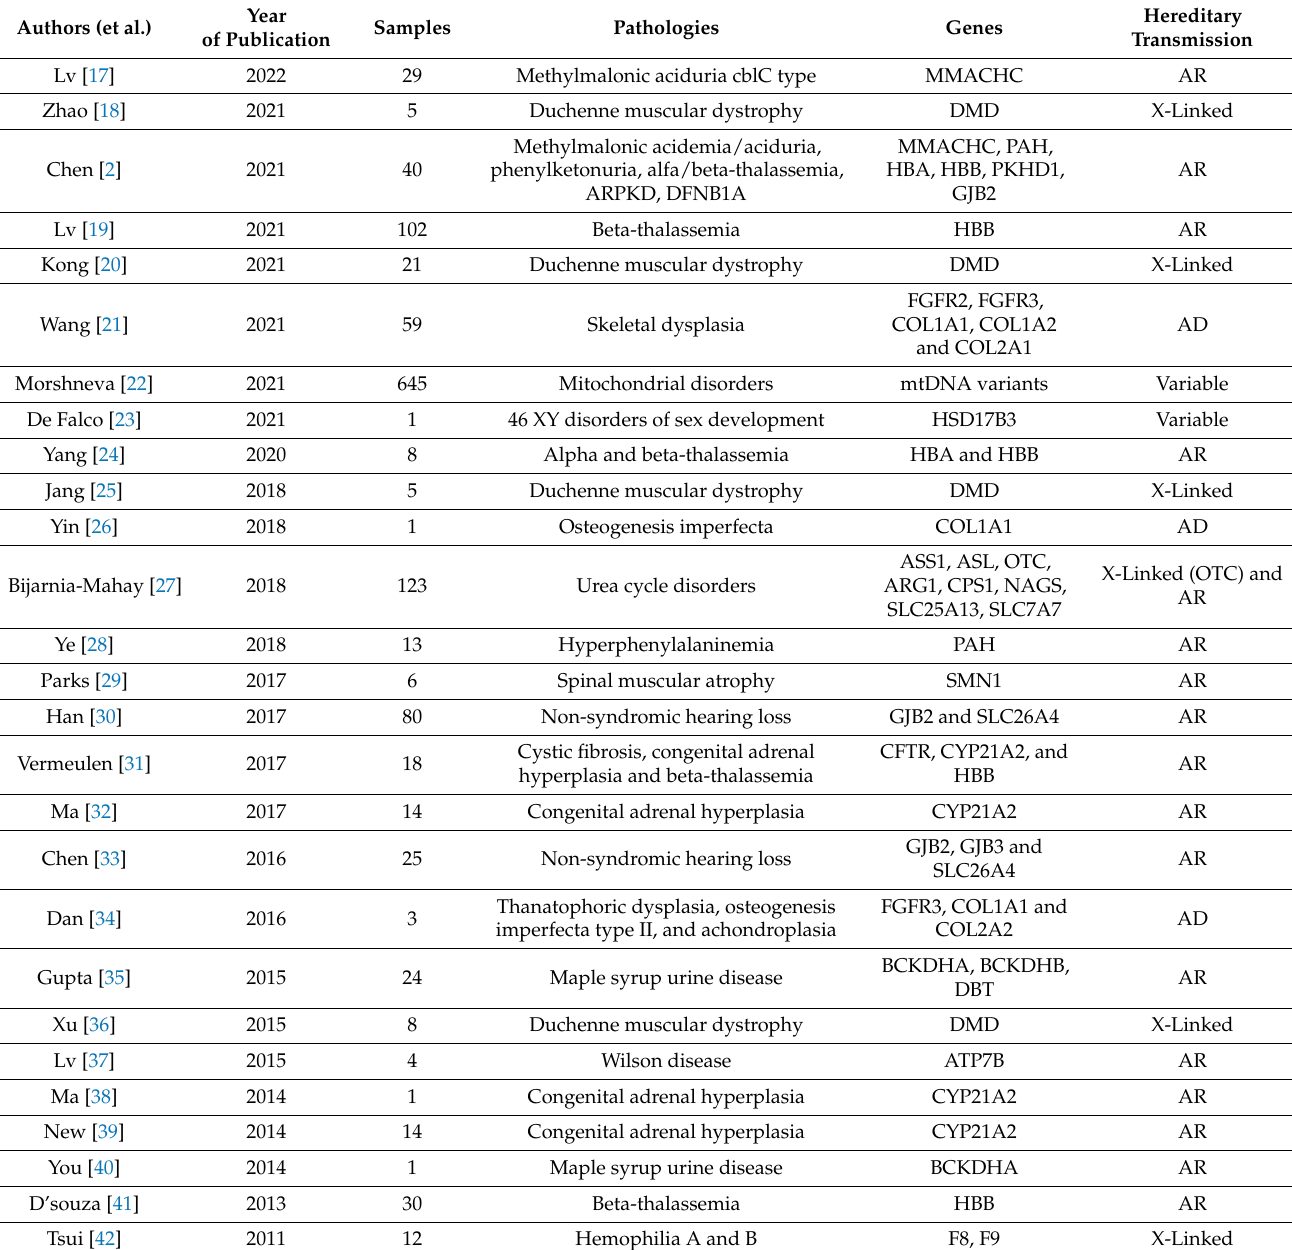
Table 3. Non-invasive prenatal diagnosis of monogenic transmission diseases and chromosomal microdeletion/duplication studies included in this